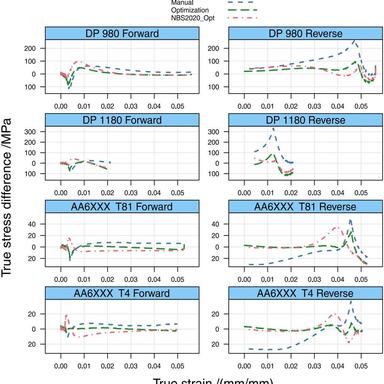
Comparison of difference between measured and computed stress-strain curves for all three methods.